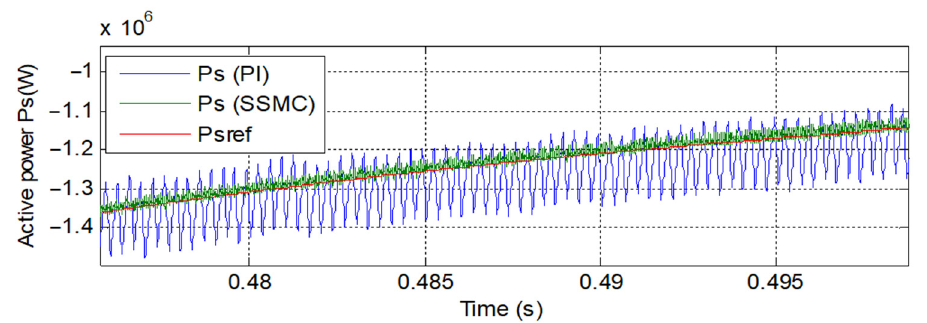
Figure 19. Zoom (Active power).